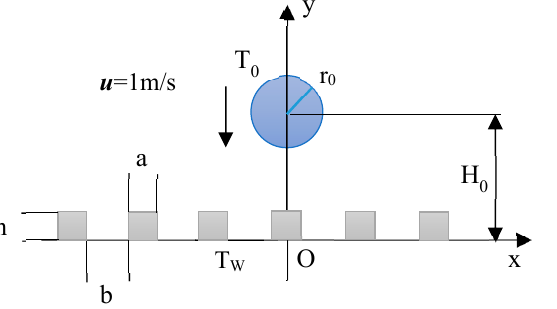
Figure 1. Geometric model of the LN 2 droplet impinging on a copper surface. Some assumptions were considered for the vaporization mechanism of the LN 2 droplet in